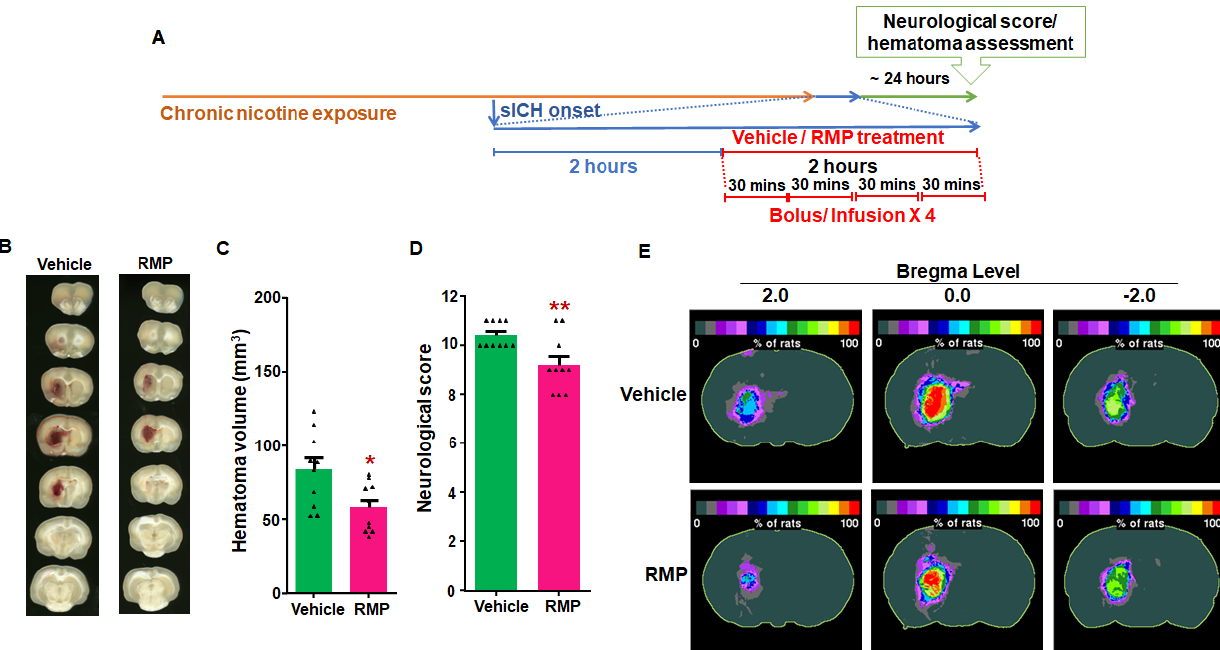
Figure 2. The effect of RMP treatment on hematoma expansion post-sICH in nicotine-exposed female rats: ( A ) representation of experimental design; ( B ) example images of brain scans showing mean hematoma volume; ( C ) mean hematoma volume data; ( D ) mean neurological score data; and ( E ) hematoma frequency maps at 3 coronal levels (bregma +2.0 mm, 0.0, and − 2.0 mm). The top row depicts the hematoma frequency maps of vehicle-treated rats, and the bottom row shows the hematoma frequency maps of RMP-treated rats. N = 10 for vehicle and RMP-treated groups, respectively; * p < 0.05 and ** p < 0.01 vs. vehicle group.